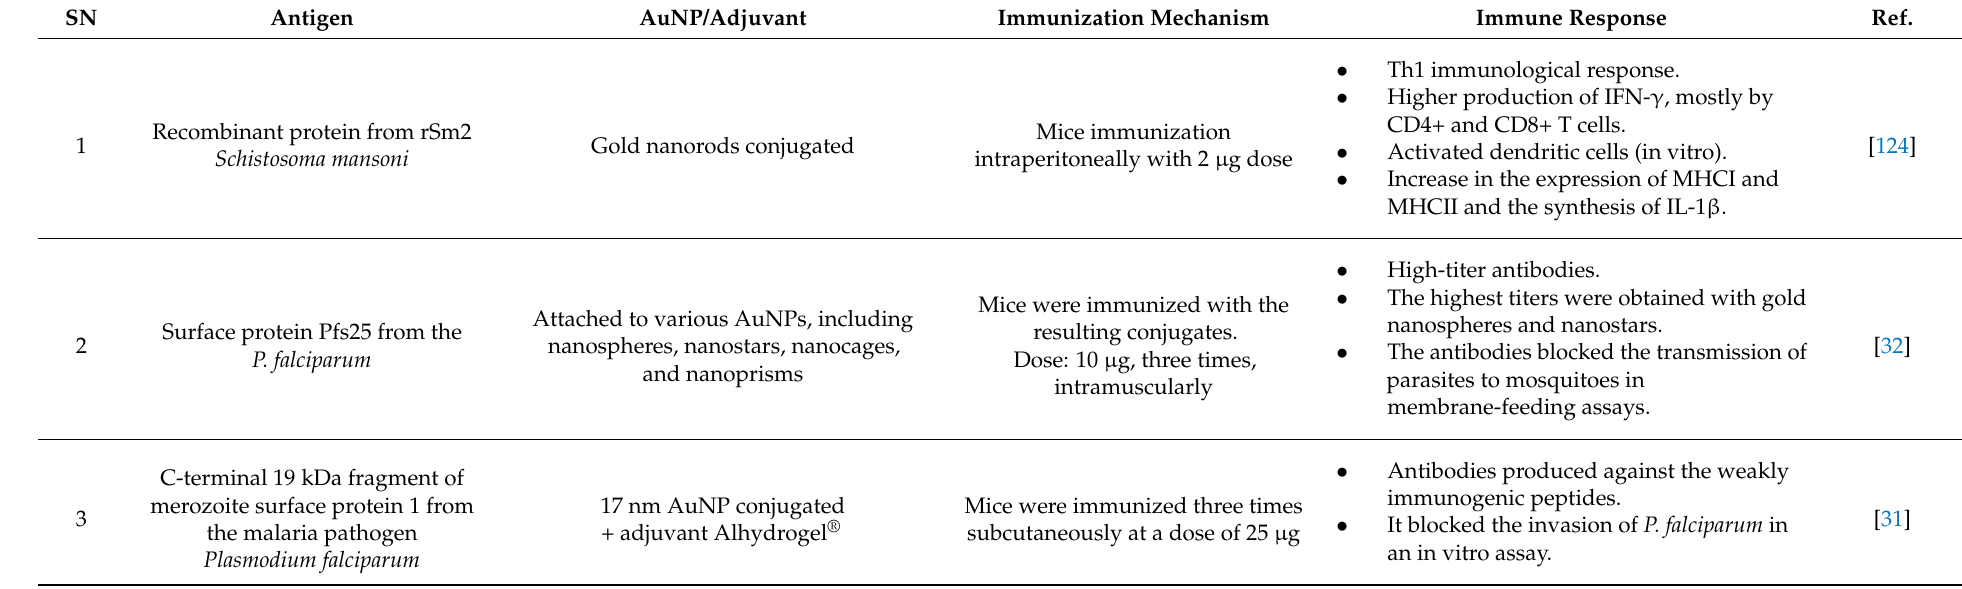
Table 3. Use of GNP based nanovaccine against parasitic